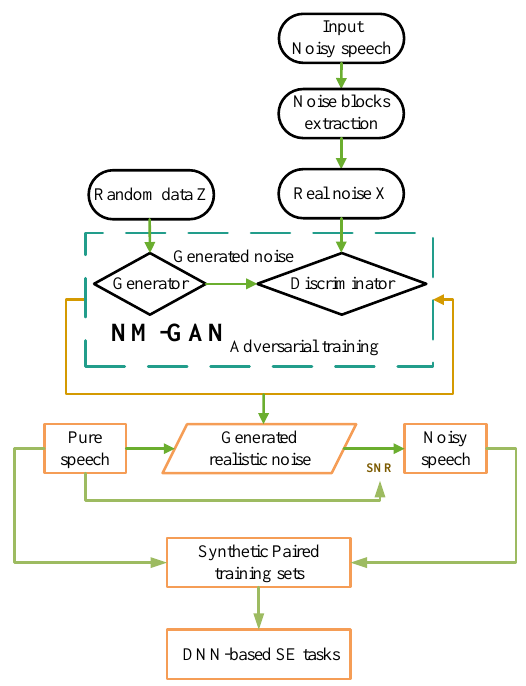
Figure 1. Proposed NM-GAN for creating synthetic training sets.